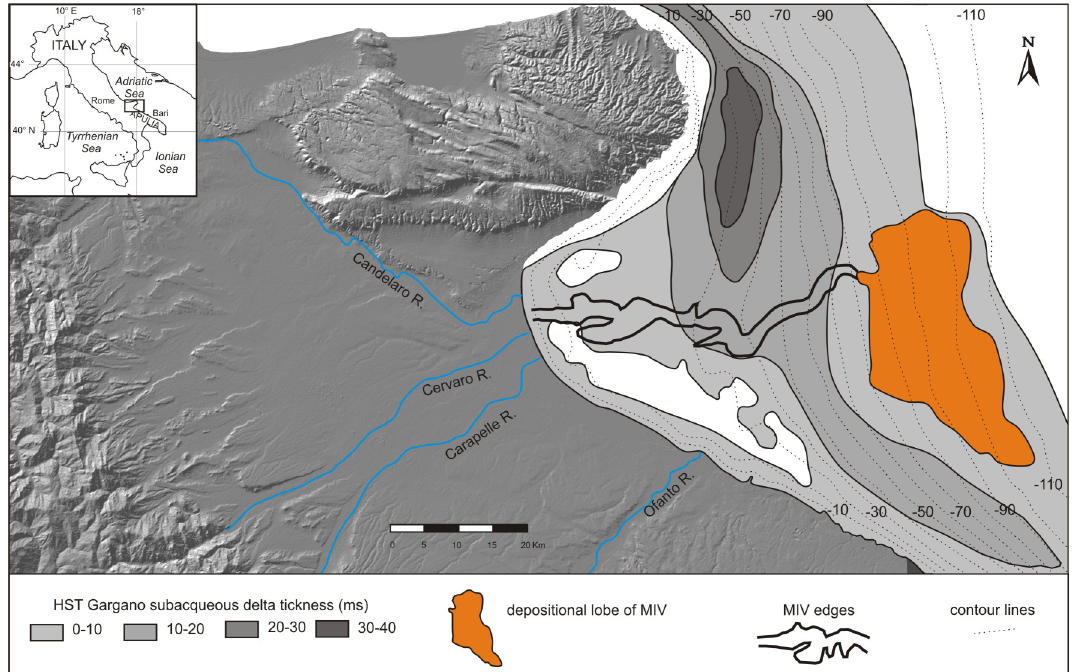
Figure 1. Simplified map showing position of the Manfredonia Incised Valley (MIV) and of its depositional lobe, high-stand system tract (HST) Gargano sub-acqueous delta (gray tones) and bathymetry of the Manfredonia Gulf shelf with 10-m-spaced contours. Redrawn from literature data [29,31,32].